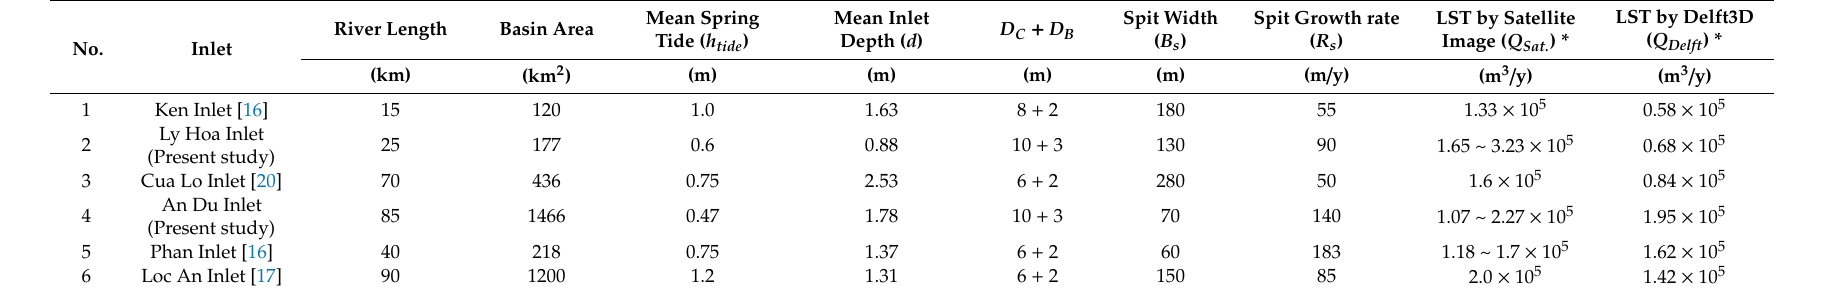
Table 3. Summary of major morphodynamic characteristics of six tidal inlets in the central coast of